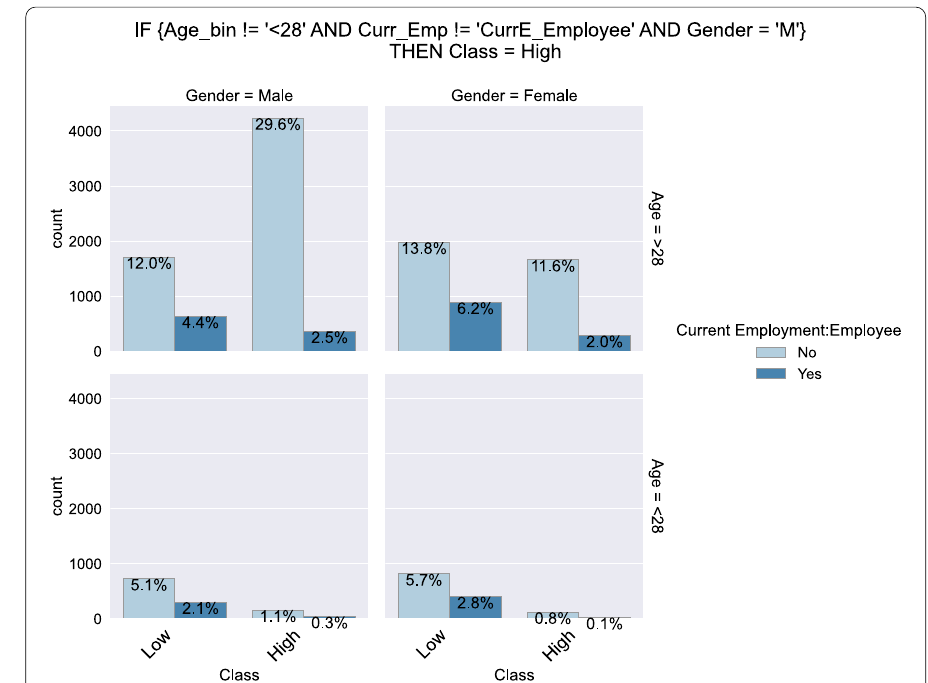
Fig. 19 Visualization of the second contrast pattern of binarized Age, Current Employment, and Gender variables in bar plot